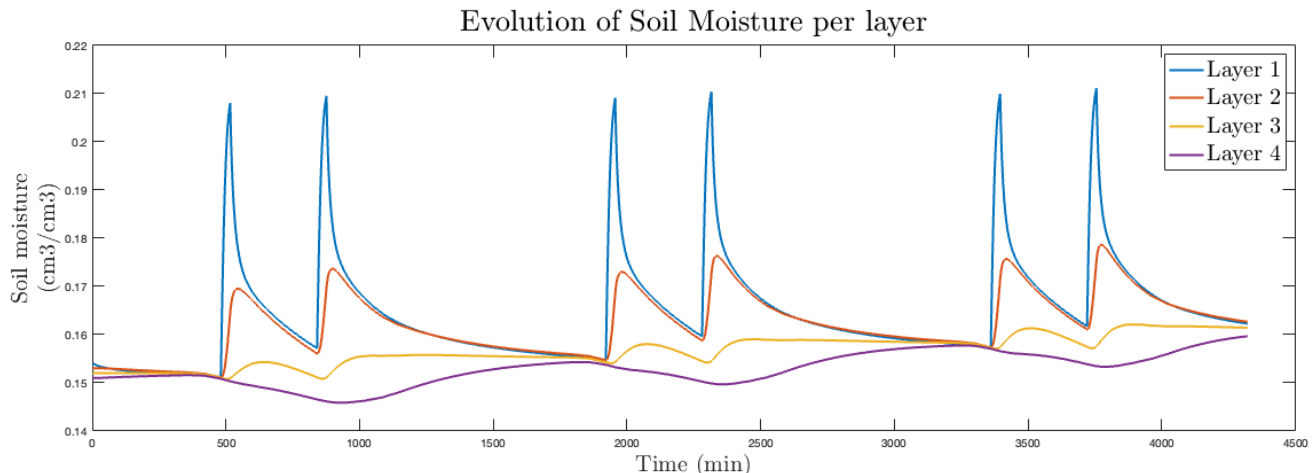
Figure 7. Soil moisture dynamics per soil layer for the classical irrigation strategy.